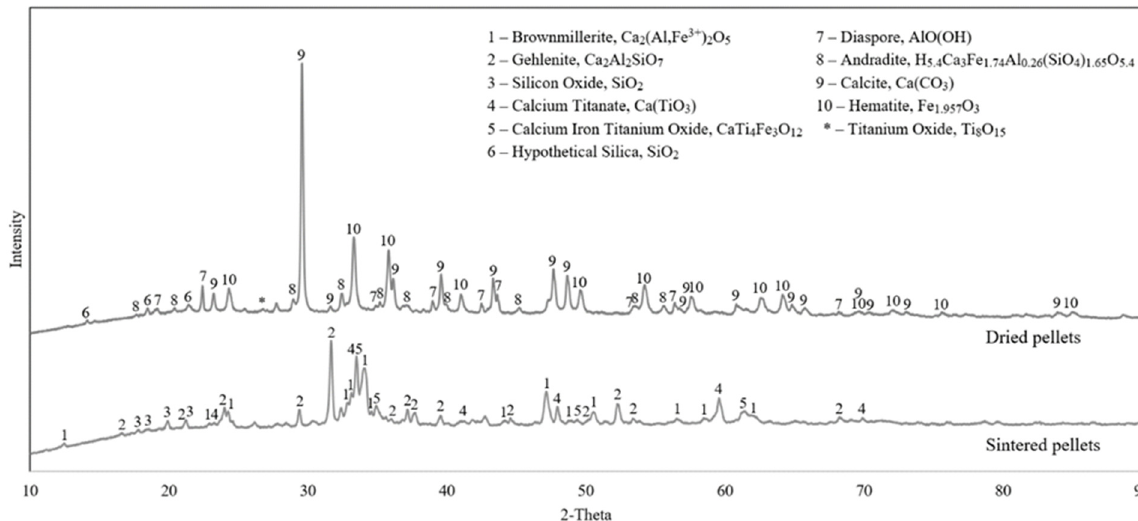
Figure 3. XRD analyses of the dried pellets ( top ) and sintered pellets ( bottom ).